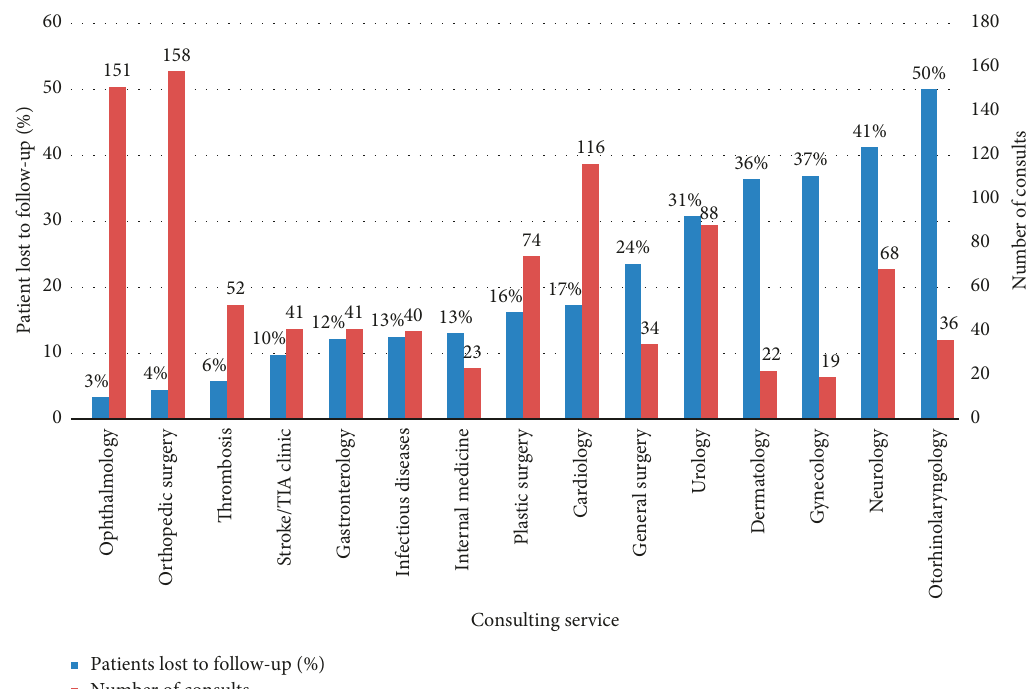
Figure 2: Outpatient consultations and patients lost to follow-up for frequently consulted services for emergency department patients.